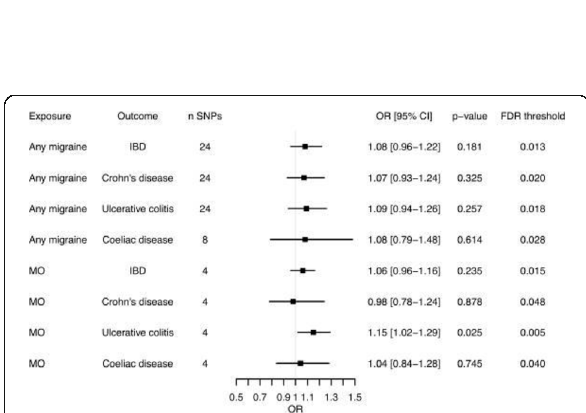
Fig. 2 (abstract P127). Effects of genetic liability to migraine on gastrointestinal conditions. Forest plot of two-sample MR effect estimates for migraine on IBD and coeliac disease based on the inverse-variance weighted